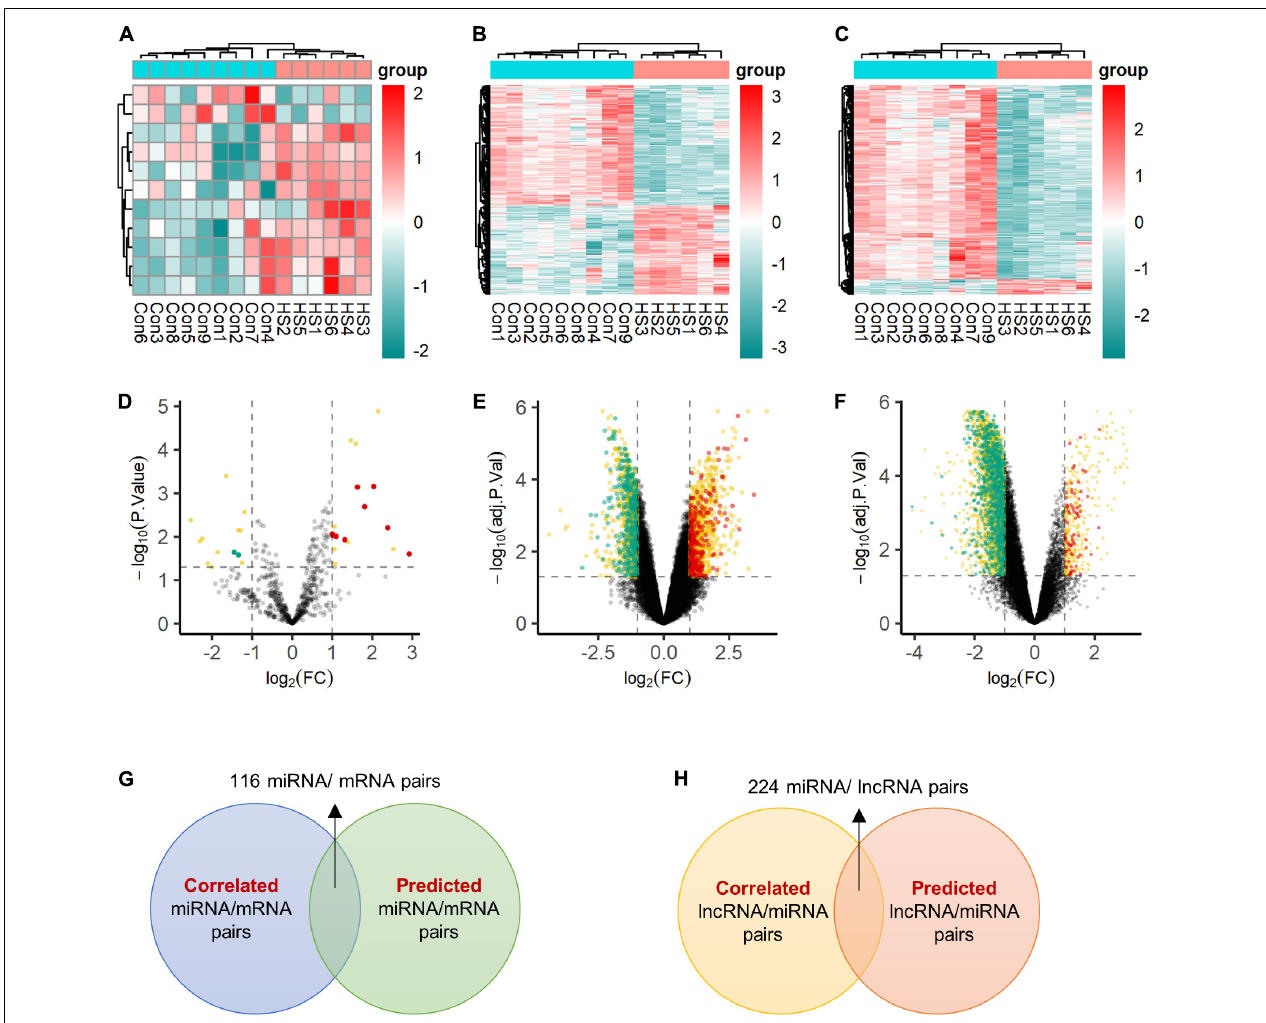
FIGURE 2 | Expression profiles of differentially expressed transcripts. Two-dimensional hierarchical clustering of the significantly differential signatures of miRNA (A) , mRNA (B) , and lncRNA (C) in six patients with TLE+HS and nine of NTP (TLE+HS in blue, NTP in red). Signatures are in rows, samples are in columns. Volcano plots of differential expressed miRNA (D) , mRNA (E) , and lncRNA (F) . Red dots represent up-regulated signatures, green dots represent down-regulated signatures, yellow dots represent false positive differential expressed signatures filtered by BrainSpan database. (G) Intersect of correlated miRNA/mRNA pairs and